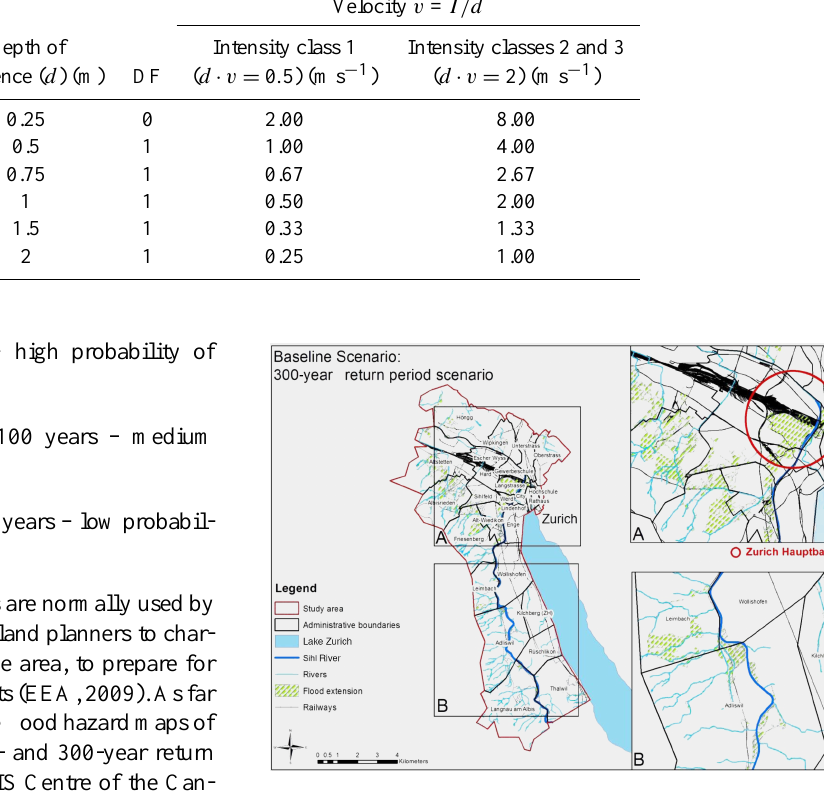
Figure 3. Baseline scenario for Sihl case study of a 300-year return period flood scenario; inset A shows the Zurich central station, inset B the upstream river valley